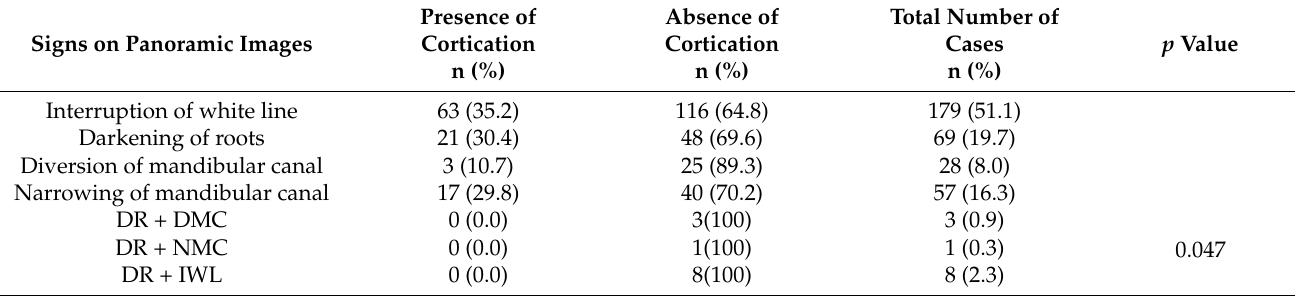
Table 2. Relationships between signs on panoramic images and cortication